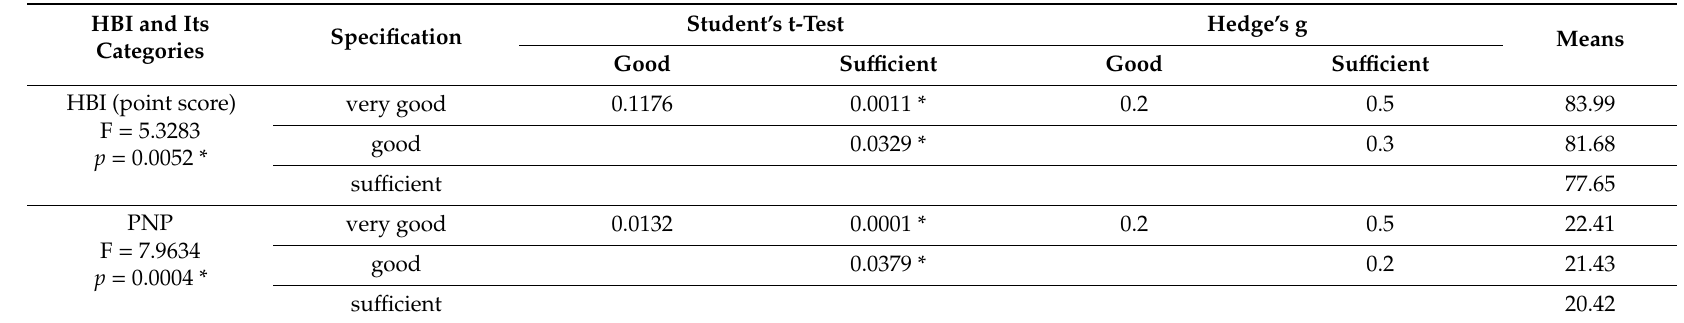
Table 7. Health behaviors of people who practice CS and MA, in relation to the self-evaluation of their financial situation (F-test, Student’s t-test, Hedge’s g). HBI and